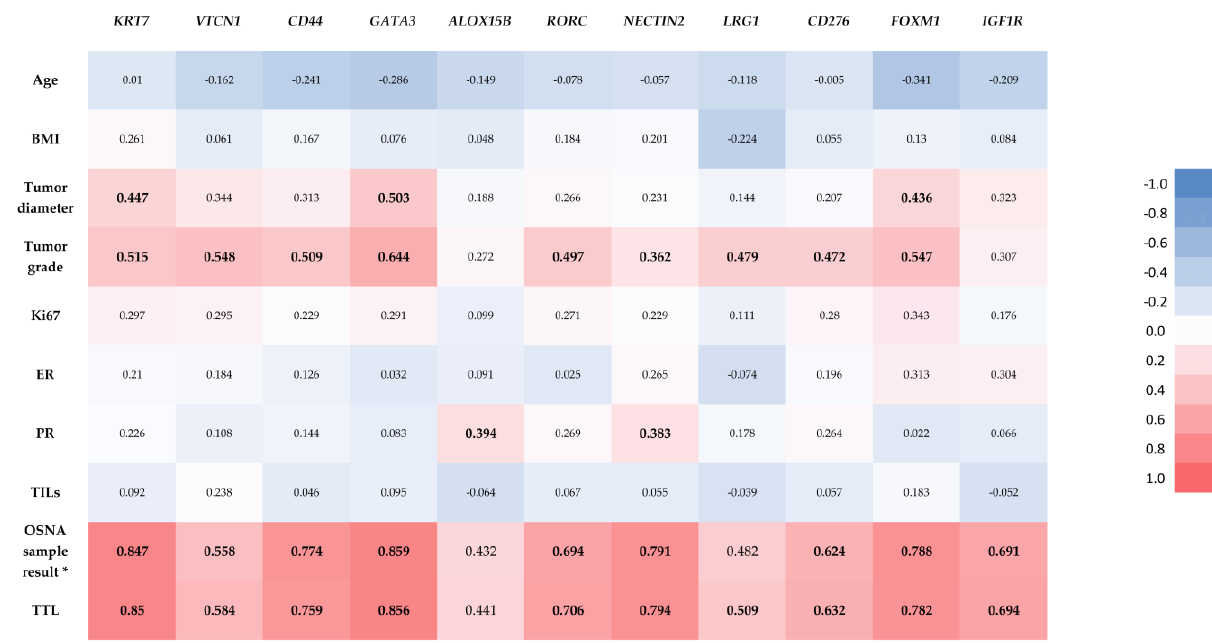
Figure 4. Correlation heatmap with results of Spearman correlation between relevant clinicopathologic parameters and the normalized expression levels of the 11 identified differentially expressed genes. Statistically significant correlations are marked in bold. * CK19 mRNA copies/μL in the selected sample of the OSNA positive samples. The result in OSNA negative samples (< 160, non-specified) did not allow Spearman correlation.